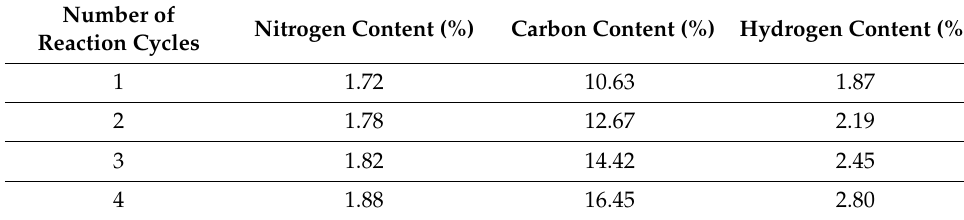
Table 1. Elemental composition of prepared series of anion